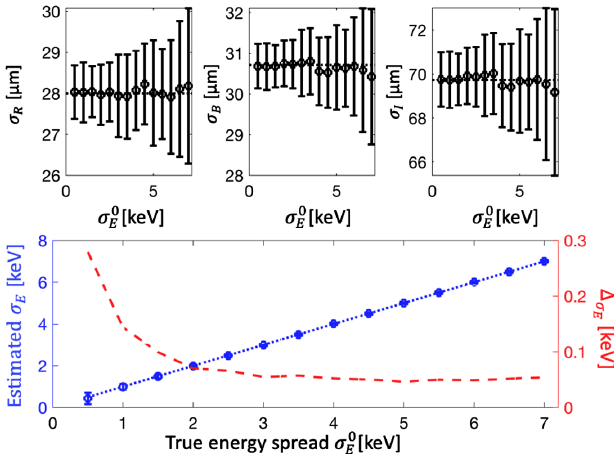
FIG. 3. Performance of the method based on dispersion scan. Circles shows reconstructed mean values. Error bars give the standard deviation error. The red dashed curve presents the rms error of the reconstruction. Dotted black curves show true values used for the simulation.